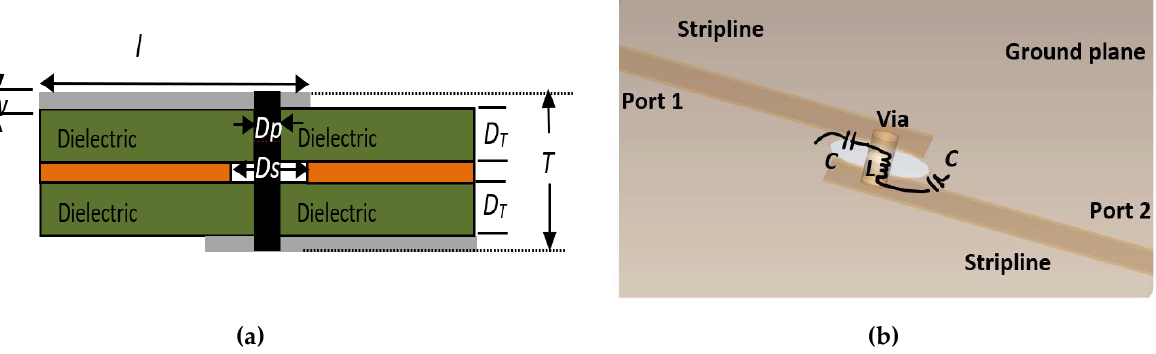
Figure 7. Configuration of via-hole with strip line ( a ) configuration and ( b ) simulation design.